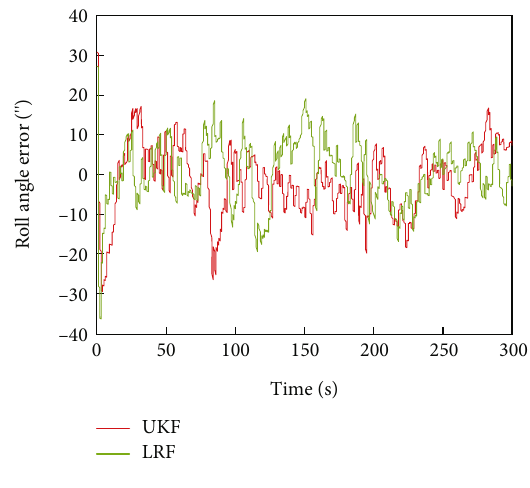
Figure 6: Roll angle error contrast curves.